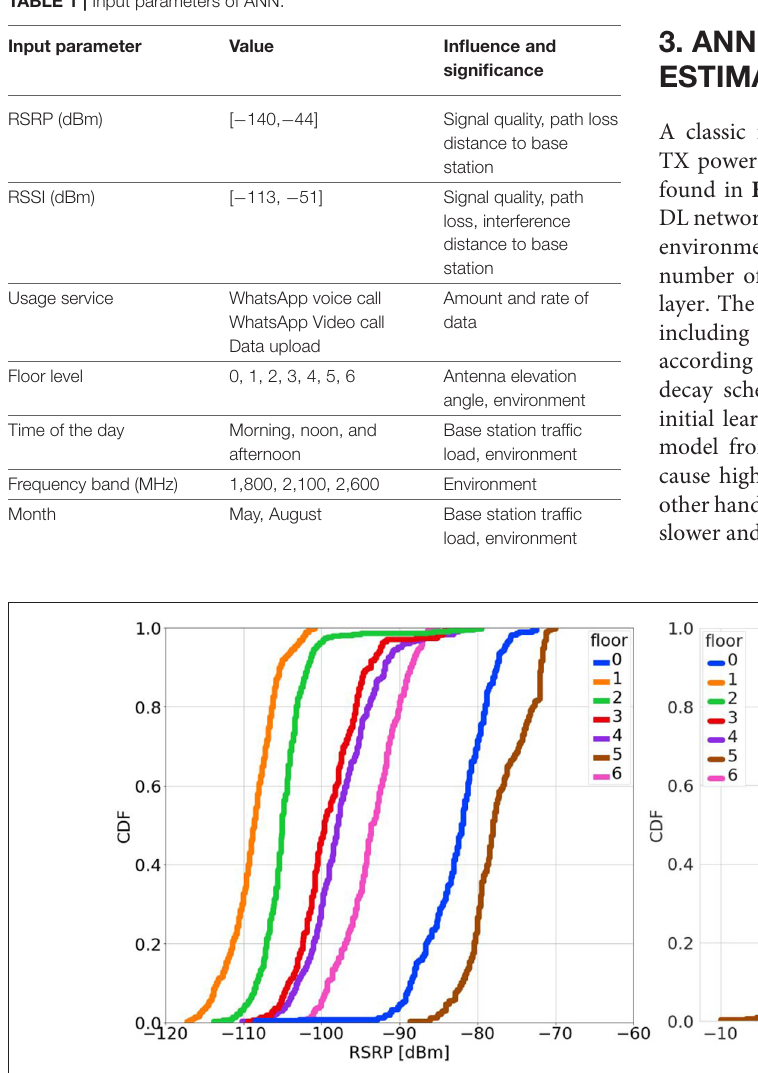
FIGURE 3 | Statistical distribution of reference signal received power (RSRP) and transmit (TX) power at different floors.